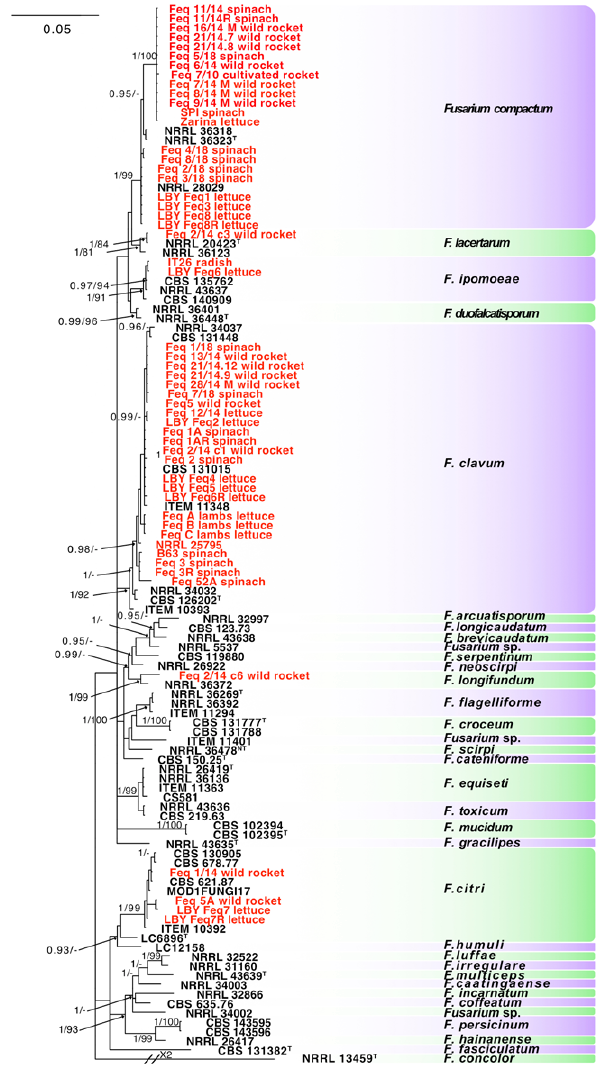
Figure 1. Consensus phylogram of 5334 trees resulting from a Bayesian analysis of the combined tef1 and cmdA sequences from different isolates of the Fusarium incarnatum-equiseti species com- plex (FIESC). The isolate designation, host affiliation and fungal species of the 52 isolates used in this study are shown in red. Bayes- ian posterior probability (> 0.95) and bootstrap support values (> 70%) are shown at the nodes. The tree was rooted to Fusarium con- color (NRRL 13459). Ex-type and neotype strains are indicated with T and NT ,